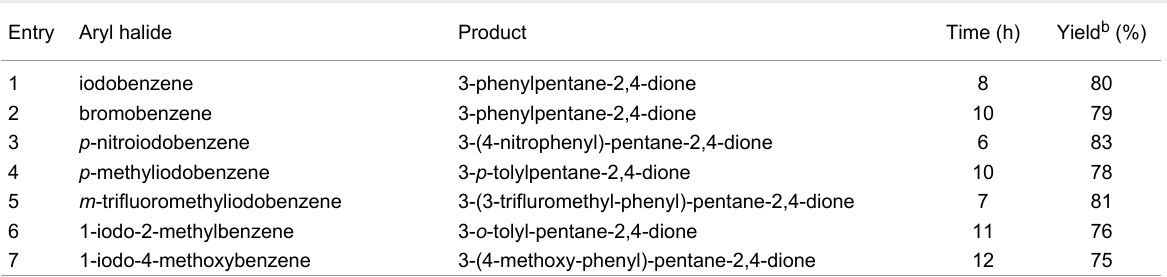
Table 3: C-arylation of acetylacetone using different aryl halides a Entry Aryl halide